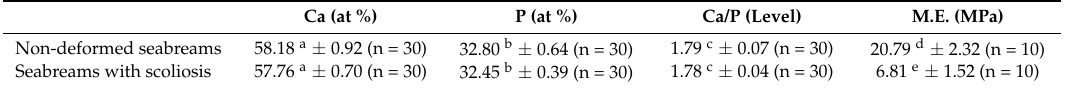
Table 4. Ca/P levels and modulus of elasticity (M.E.) of seabreams’ vertebrae.